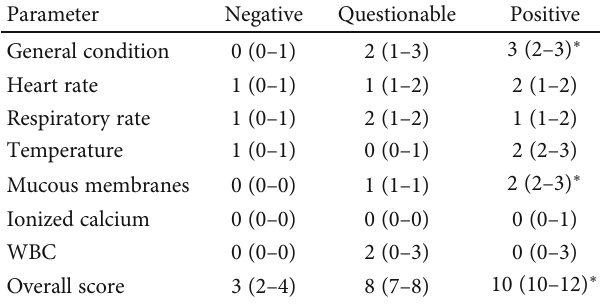
Table 3: Results of sepsis scoring in the groups negative ( n = 32 , ≤ 6/19 points), questionable ( n = 8 , 7-9/19 points), or positive ( n = 6 , ≥ 10/19 points) for sepsis; median (lower quantile – upper quantile). Signi fi cant di ff erences in comparison with the sepsis negative group are marked as ∗